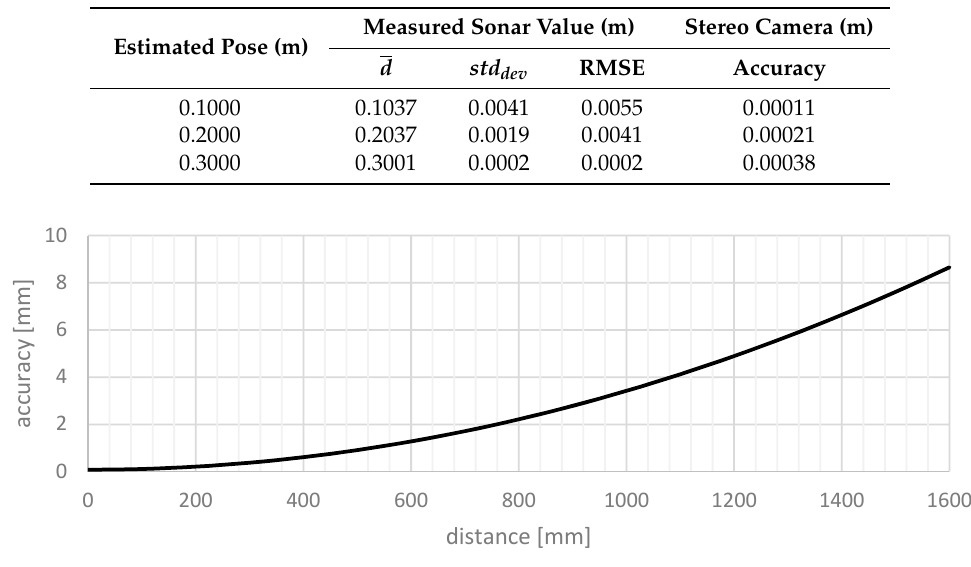
Figure 3. Development of the accuracy of a stereo vision system, with the assumed parameters B = 300 mm, f = 10 mm and p = 5 µm (see Equations (4) and (5)).